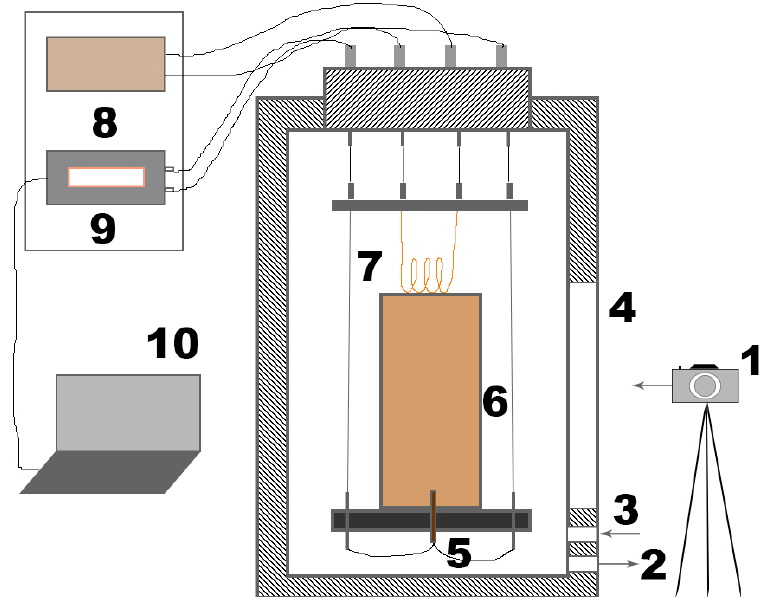
Figure 1. Schematic of the laboratory high-pressure SHS reactor. 1—video camera, 2—outlet to the vacuum pump, 3—nitrogen inlet, 4—window for video recording, 5—thermocouple, 6—gas-permeable container with the powder, 7—heating coil, 8—electric pulse source, 9—transformer, and 10—computer.